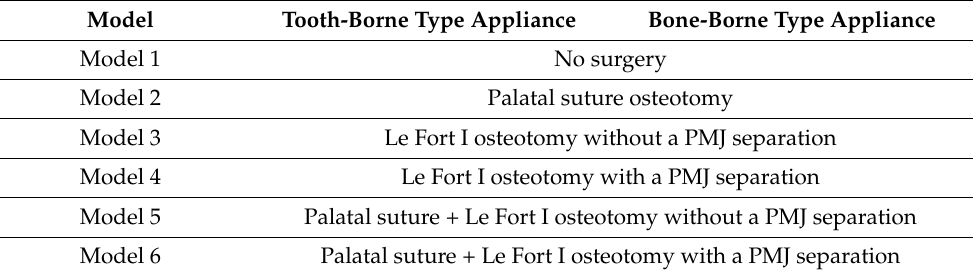
Figure 4. Schematic representation of the osteotomy line on the 3D finite element model of the facial skeleton. Red colour—palatal suture osteotomy; yellow colour—Fort I osteotomy without a PMJ separation; blue colour—total Le Fort I osteotomy. Table 2. A detailed course of the modelled osteotomies and the order in which the maps of the reduced stresses according to Huber are presented in the figures.